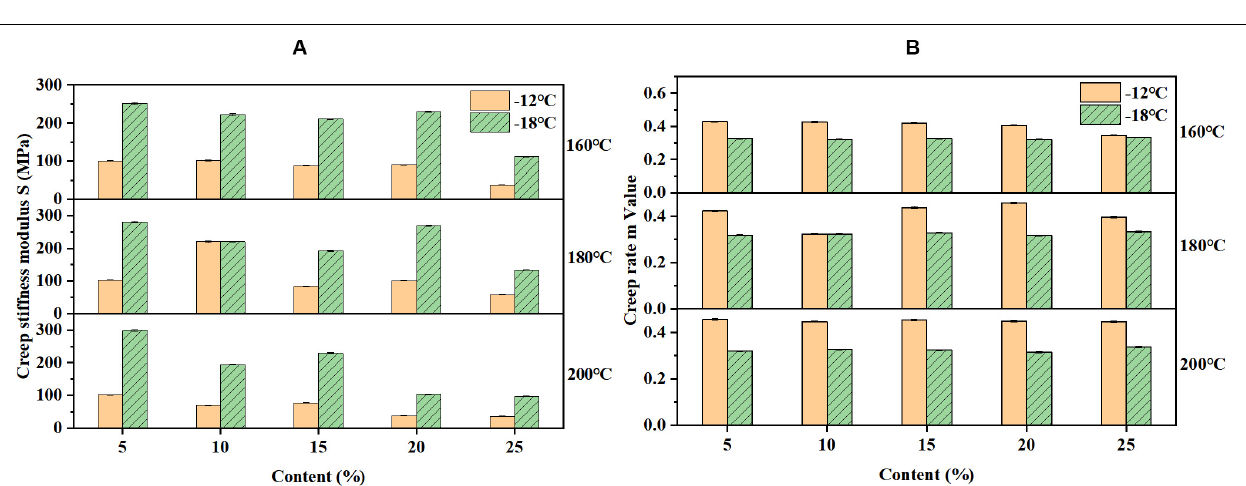
Frontiers in Materials |